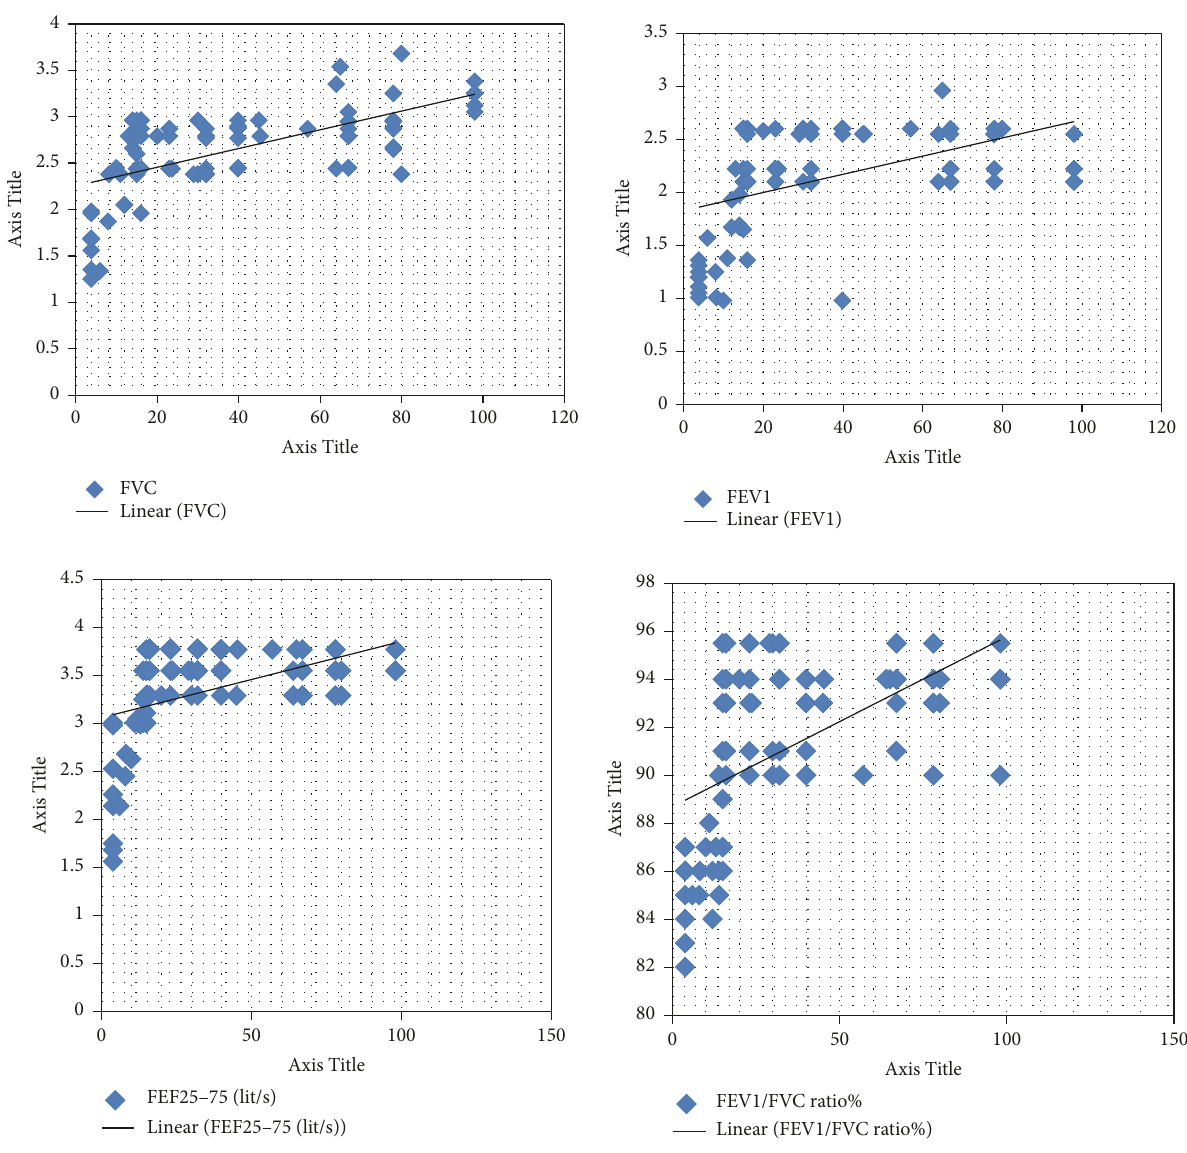
Figure 1: Positive correlation of the serum 25(OH)D with indices of spirometry test in healthy individuals. FVC, forced vital capacity; FEV1, forced expiratory volume in 1 second; FEF25–75%, maximum mid-expiratory flow or forced expiratory flow